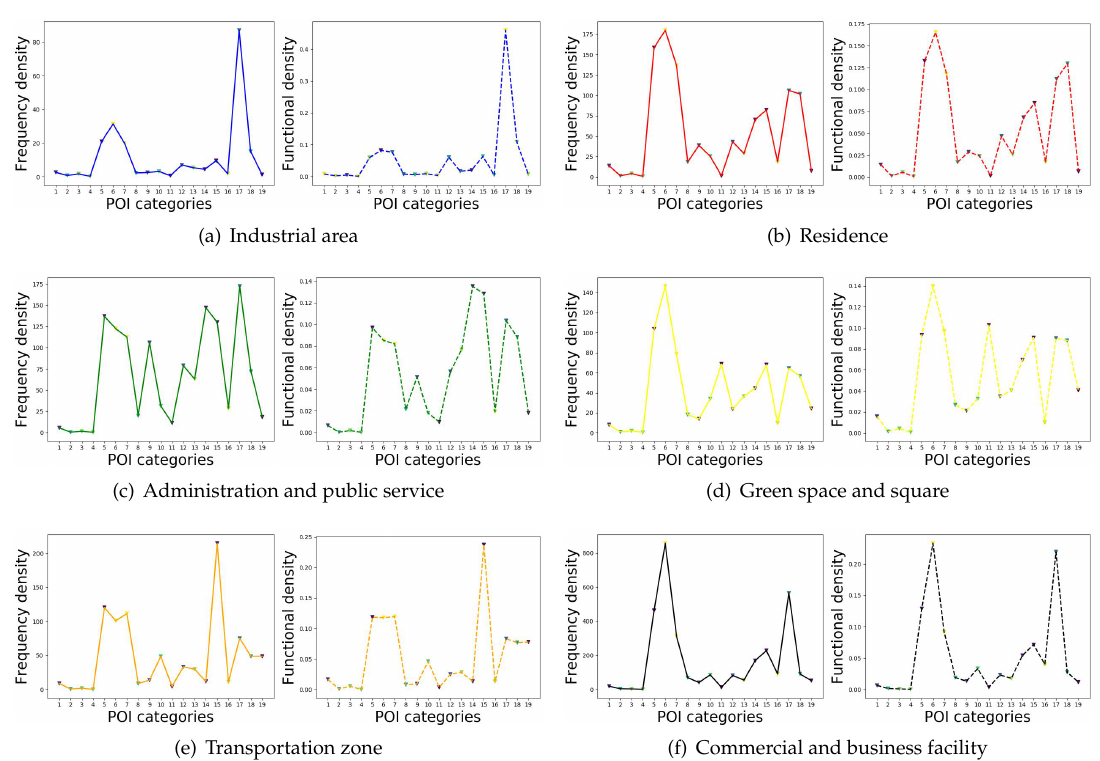
Figure 11. The POI categories distribution in terms of Frequency density (bold line) and Functional density (dash line) for various urban functional